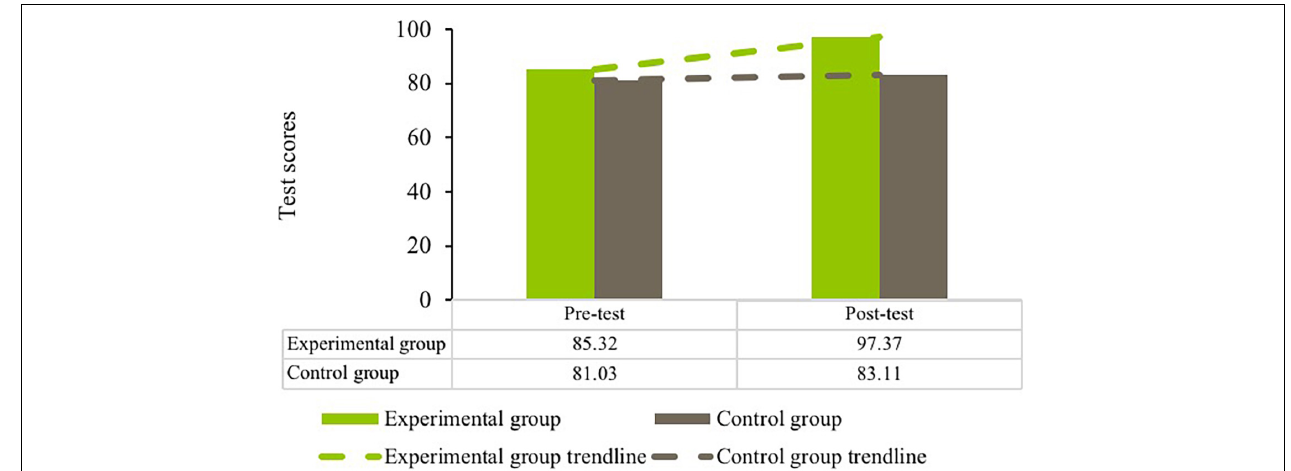
FIGURE 8 | Participants’ test scores in pre- and post-tests.